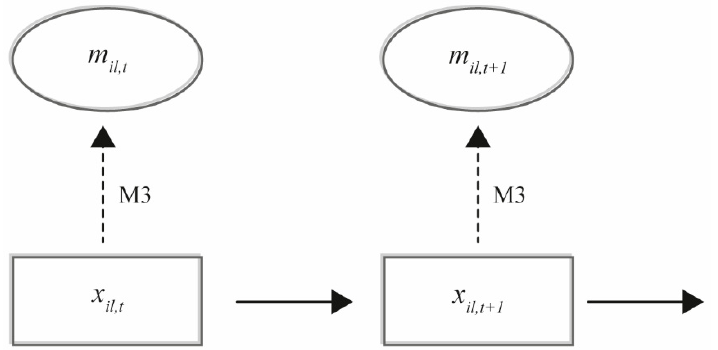
Figure 2. Hierarchical population ecological model fitted to image data from a selected “vegetation plot” l that has the same size as the ground-truthing plots, but where only image data are available. The true, but unknown, vertical density of species i at time t is modeled by the latent variable x il , t and the solid arrows are the process equation (Equation (4)). The dashed arrows are the fitted measurement equations ( M 3 ) that link the vertical density predicted from the information from the drone images ( m ij ) to the latent